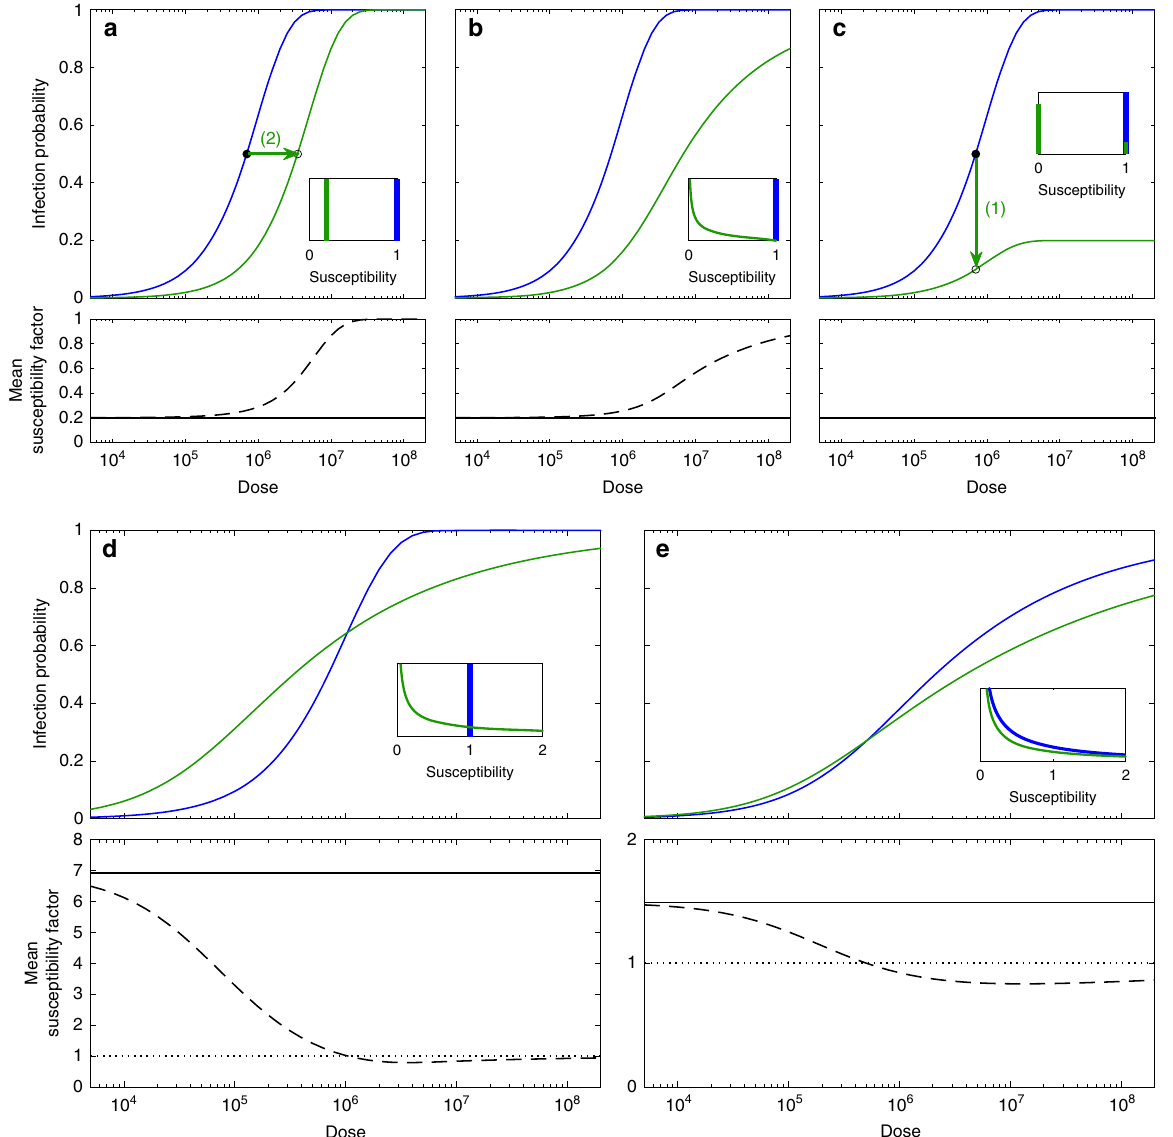
Fig. 2 Distributions of susceptibility factors and their impact on dose – response curves. Blue dose – response curves represent infection probabilities in insects without Wolbachia , while green represent Wolbachia carriers. Insets depict distributions of susceptibility in noncarriers (blue) and carriers (green) normalised such that noncarriers have mean susceptibility one. Solid black lines represent the mean susceptibility of Wolbachia carriers, while dashed black curves mimic common procedures based on simple arithmetic ratios of the proportions infected dose-by-dose. Top panels ( a – c ) assume distributions of susceptibility factors with the same mean, less than one (0.2), and different variances ( a , 0 (homogeneous); b , 0.0533; c , 0.160 (all-or-nothing)). Bottom panels ( d , e ) use the susceptibility distributions estimated in King et al. 1 ( d , mean 1 and variance 0 for noncarriers, and mean 6.92 and variance 143 for carriers; e , mean 1 and variance 2.78 for noncarriers, and mean 1.49 and variance 10.9 for carriers). The threshold separating increased from reduced mean susceptibility is marked by dotted black